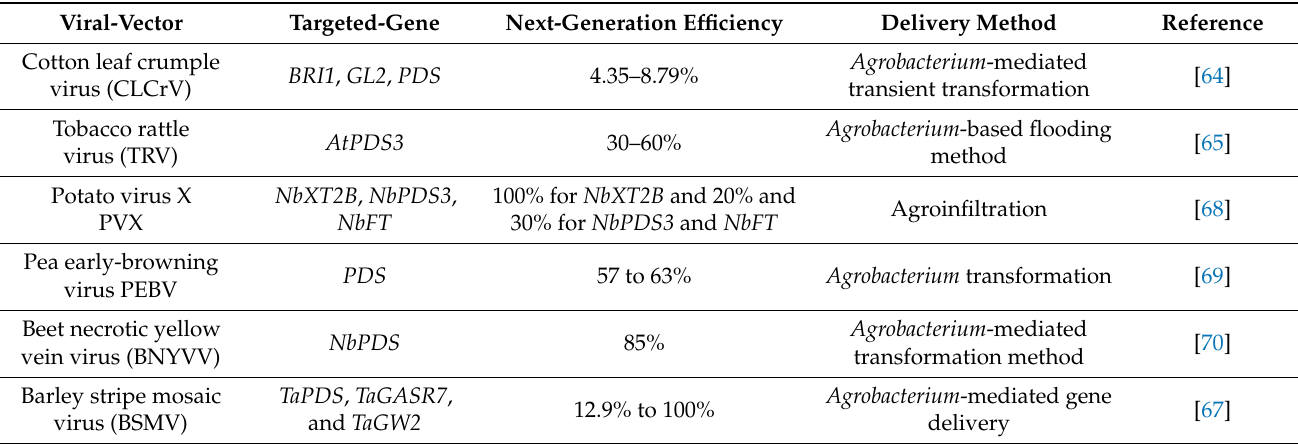
Table 1. Viral-Vector Used for Heritable Genome